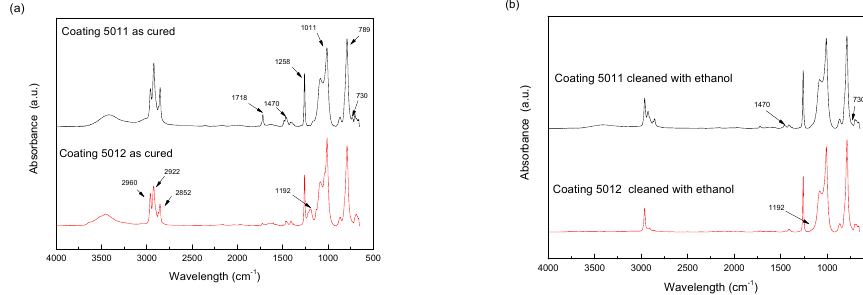
Figure 2. Infrared spectrum curve of studied coatings ( a ) cured ( b ) cleaned.